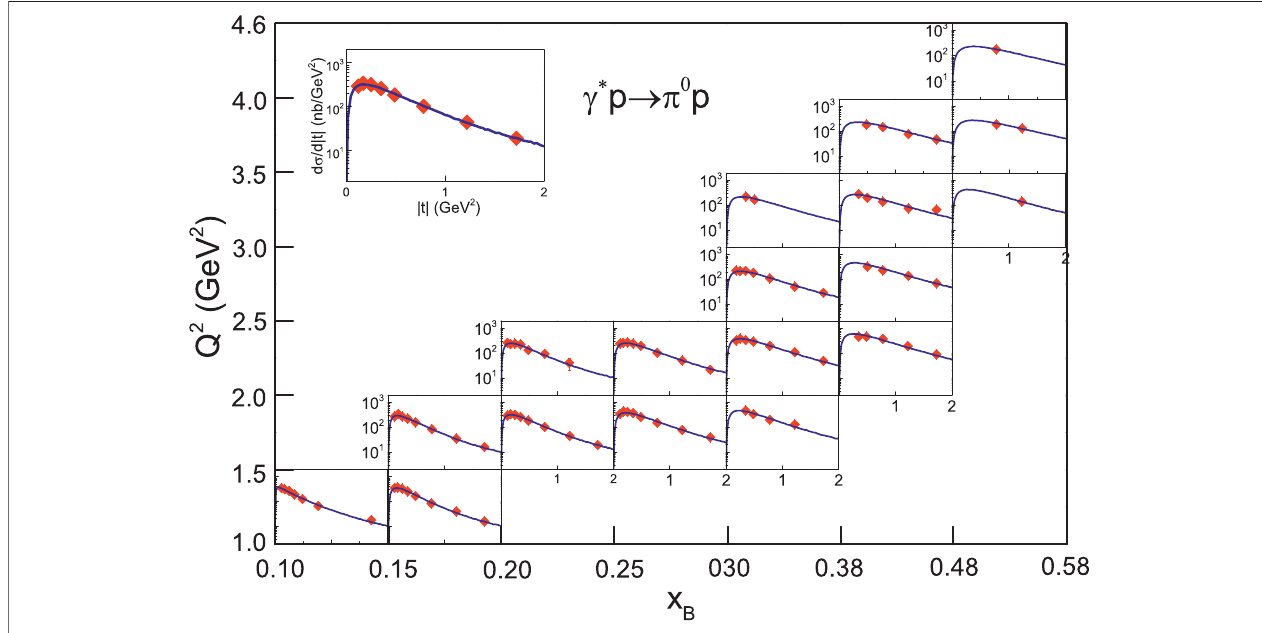
FIGURE 1 | The differential cross-section d σ / d | t | in | t | of c * p → π 0 p process produced in ep collisions at beam energy of 5.75 GeV in different ranges of Q 2 and x B showninthepanels.Thesampleatthetop-leftsub-panelshowsrepeatedlytheresultin1.5 < Q 2 < 2.0 GeV 2 and0.20 < x B < 0.25asanexample.Thesymbolsrepresent the experimental data measured by the CLAS Collaboration [37] and the curves are the statistical results of | t | ( Eq. 9 ) in which p 3 T satis fi es the Erlang distribution ( Eq. 2 ) and can be obtained with the Monte Carlo method ( Eq. 13 ).